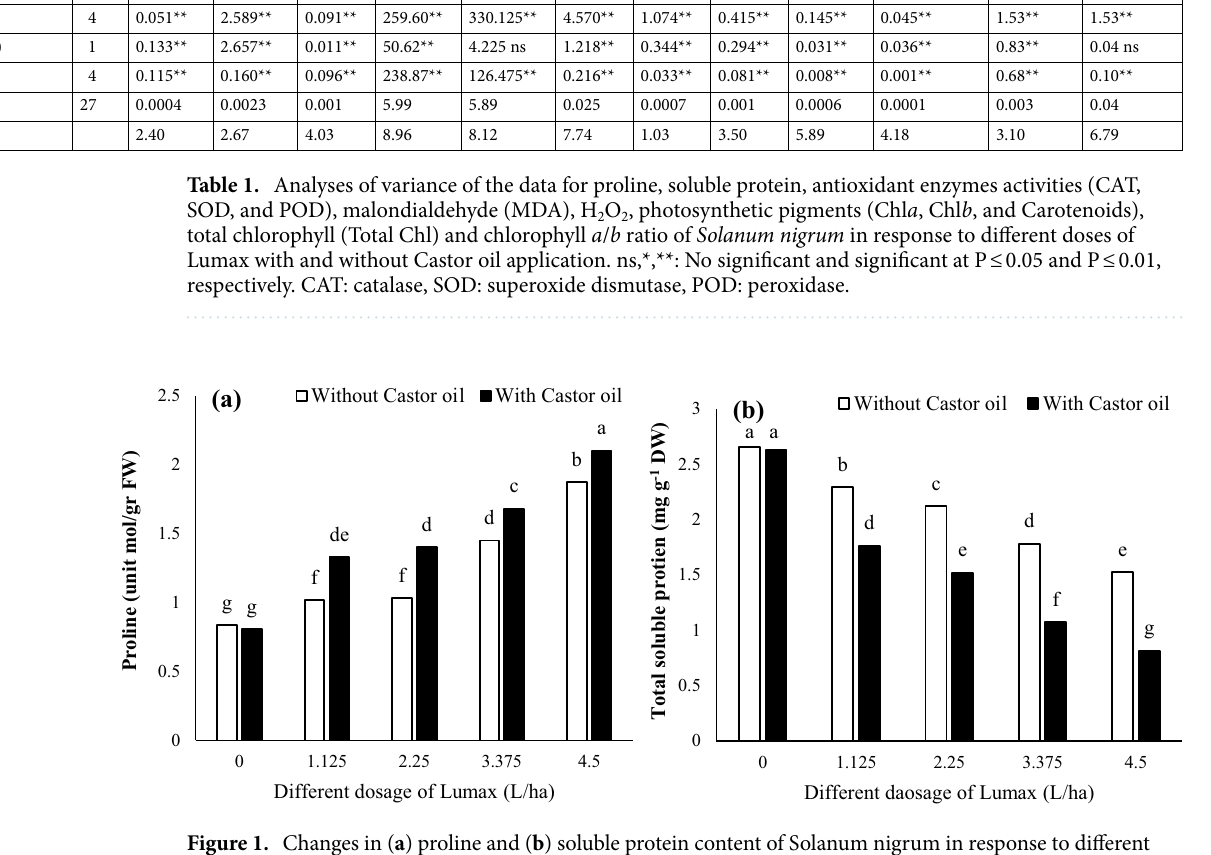
Figure 1. Changes in ( a ) proline and ( b ) soluble protein content of Solanum nigrum in response to different doses of Mesotrion + S-metolacholor + Terbuthylazine with and without Castor oil application. Each value is the mean of four replicates. Different letters represent significant differences ( P <